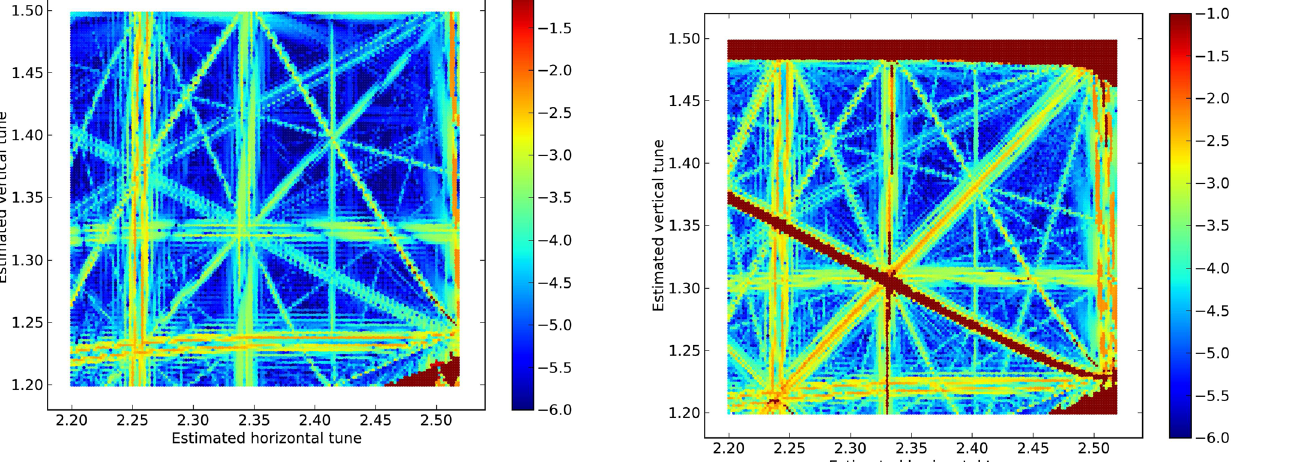
FIG. 6. D plotted as colors against the estimated tunes for the ELENA machine with electron cooler. The red dots correspond to lost